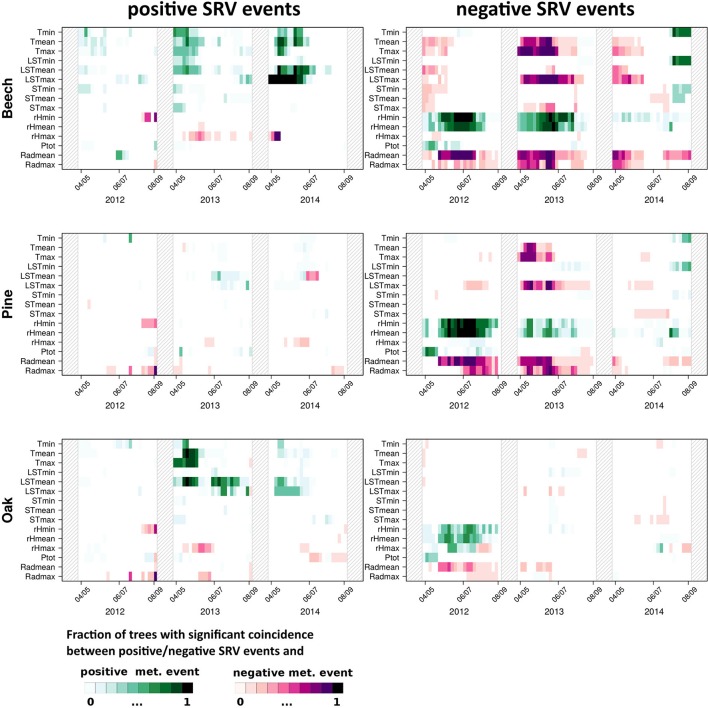
As in Figure 2 but with ΔT = 1 day and τ = 1 day.